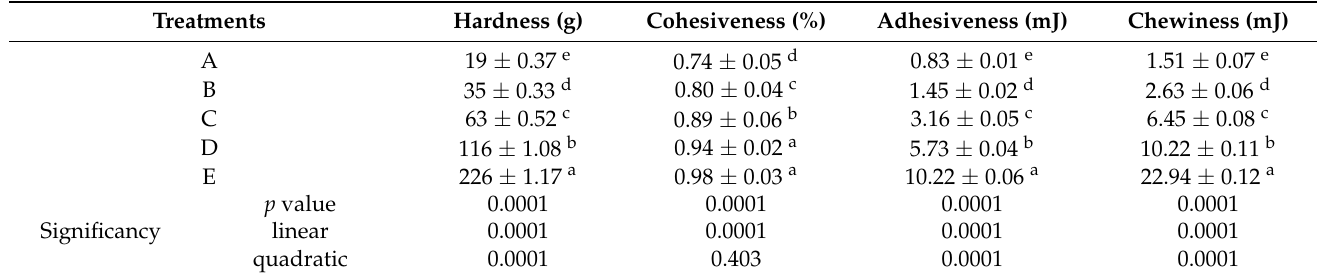
Table 3. Texture properties of date jam prepared with different amounts of powdered date press